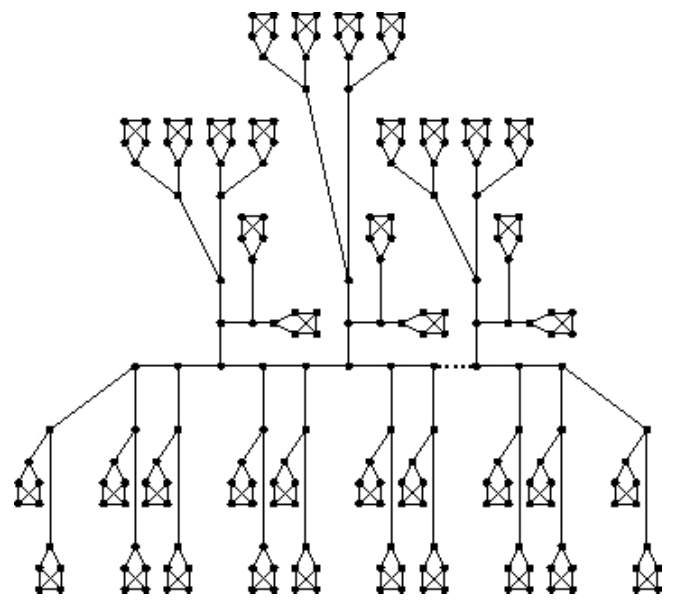
Fig. 3: An example of a class of cubic graphs with a maximum P 3 packing of not more than 4 n/ 5